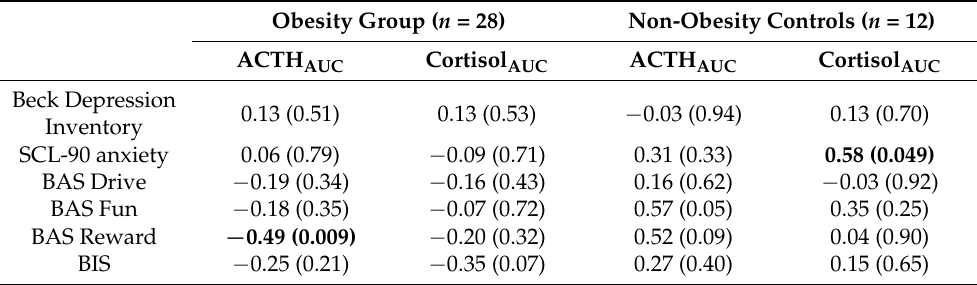
Table 4. Spearman correlations of dex/CRH test indicators with questionnaires of depression, anxiety and